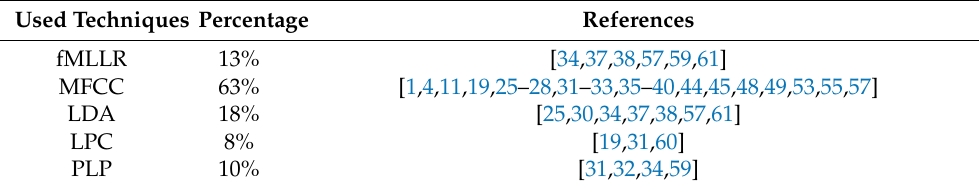
Table 8. The commonly used extraction techniques. Some studies are based on more than one technique. Then, the same study was repeated, which increased the total number of studies. Used Techniques